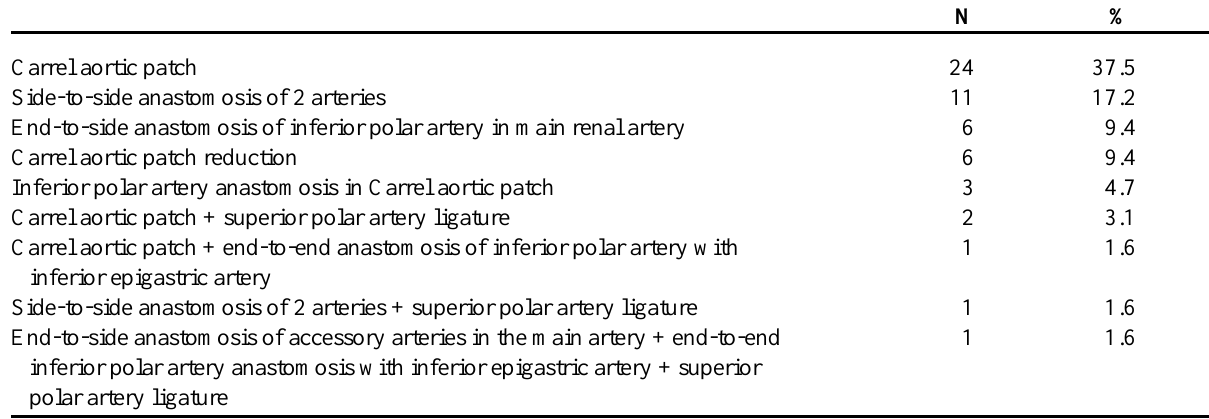
Table 2 – Bench vascular technique in multiple artery grafts.